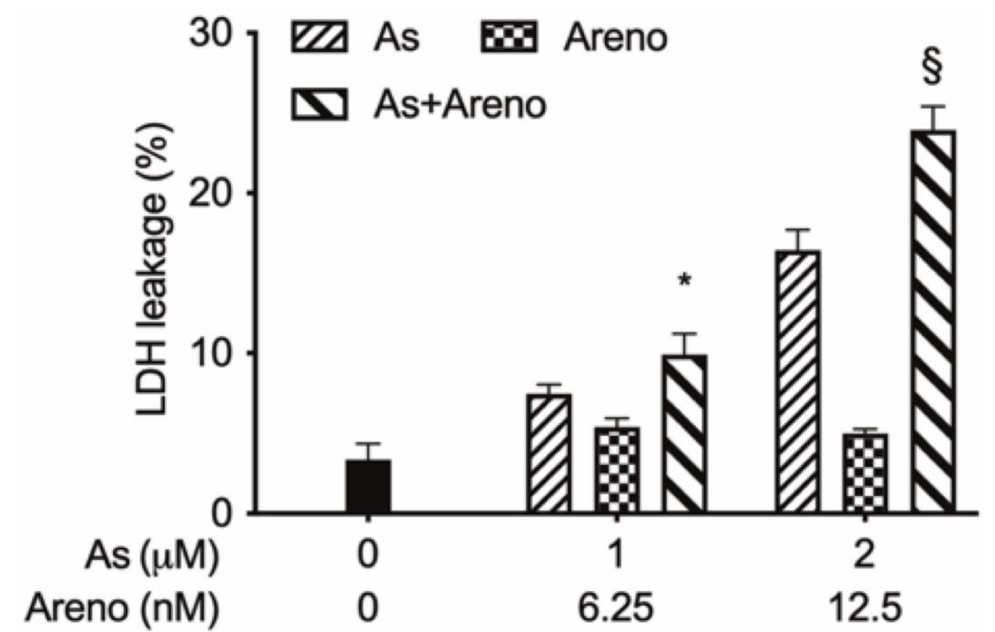
Figure 7. Enhanced LDH release in U-87 cells treated with As III combined with arenobufagin. Following treatment for 48 h with As III (1 and 2 µ M) and arenobufagin (6.25 and 12.5 nM), alone and in combination, LDH leakage was measured using the LDH-Cytotoxic test kit, as described in “Materials and Methods”. Results are shown as the means ± SD from more than three independent experiments. *, p < 0.05; §, p < 0.001 vs. each alone. As, As III ; Areno; arenobufagin.